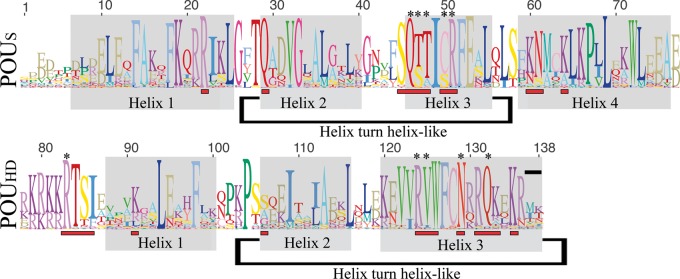
Structure and variation within the POUS and POUHD domains. Probable α-helix subdomains are shaded in gray, amino acids known to make contact with DNA in at least one POU class are marked with a red bar, and the subset which makes direct contacts with nucleotides is marked with an asterisk (based on Klemm et al. 1994; Jacobson et al. 1997; Reményi et al. 2001, 2003; Jauch et al. 2010; Esch et al. 2013). The combined height of the amino acids at each position indicates the degree of sequence conservation, whereas the height of each individual amino acid indicates its relative frequency. This figure is based on the alignment we used for our phylogenetic analyses (see Materials and Methods and supplementary file S1, Supplementary Material online), and was created using the Sequence Logo function in Geneious.